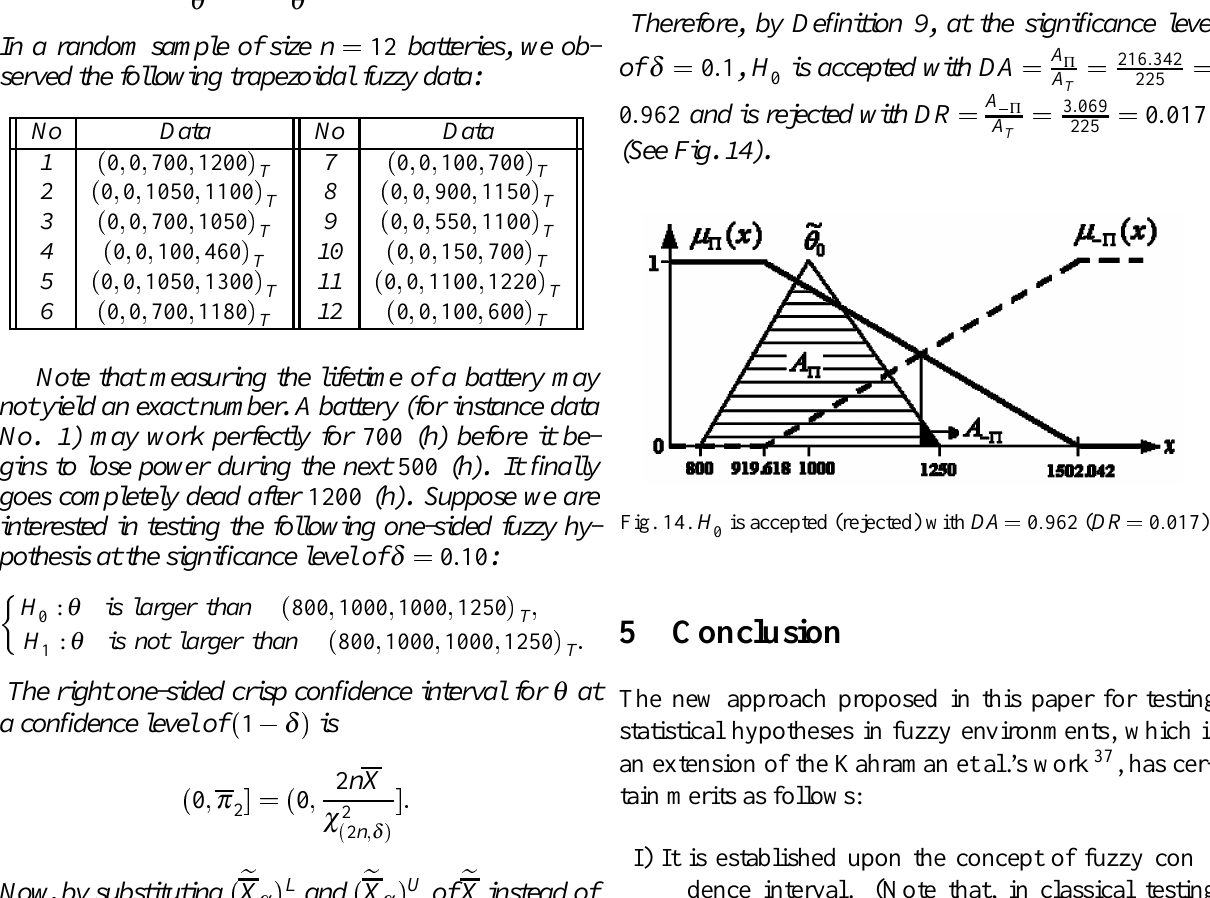
1 ( DR 0). (cid:0) (cid:0)